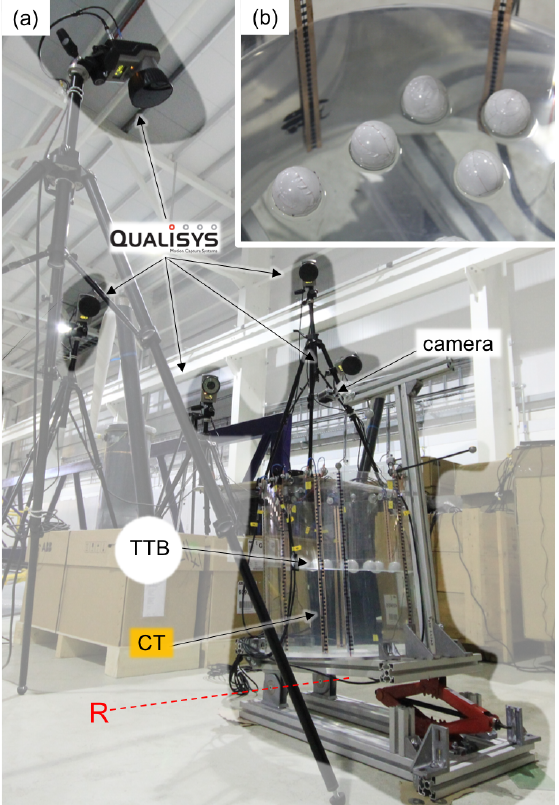
Figure 1. Experimental set-up—acrylic cylindrical tank mounted on an inclinable framework including table tennis balls (TTB) and wave gauges made of copper tape (CT)—rotation axis R —( a ) overview of the inclined structure and ( b ) detail of the inner water